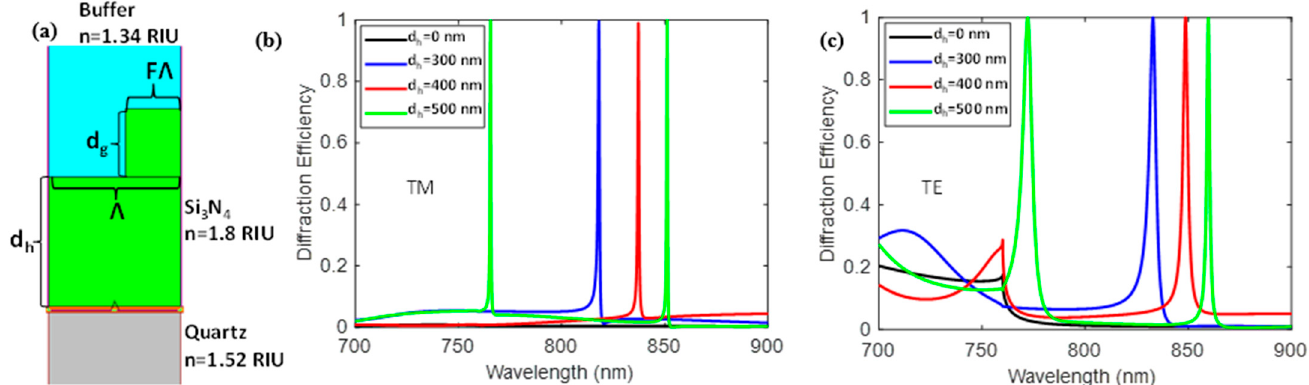
Figure 1. ( a ) The sensor used in this work consists of a silicon nitride (Si 3 N 4 ) grating and homogeneous layer on a quartz substrate. The orange horizontal line at the substrate/homogeneous layer interface represents a light source directed upward. The grating parameters are as follows: fill factor (F) = 0.42, grating depth (d g ) = 260 nm, homogeneous layer depth (d h ) = 500 nm, and period ( Λ ) = 500 nm. ( b ) The RCWA simulated zero-order TM reflection spectrum from 700 to 900 nm for homogeneous layer thicknesses 0, 300, 400, and 500 nm. ( c ) The same for the TE spectrum. TE polarization has the electric field vector normal to the plane of incidence, whereas TM polarization has the magnetic field vector normal to the plane of incidence.